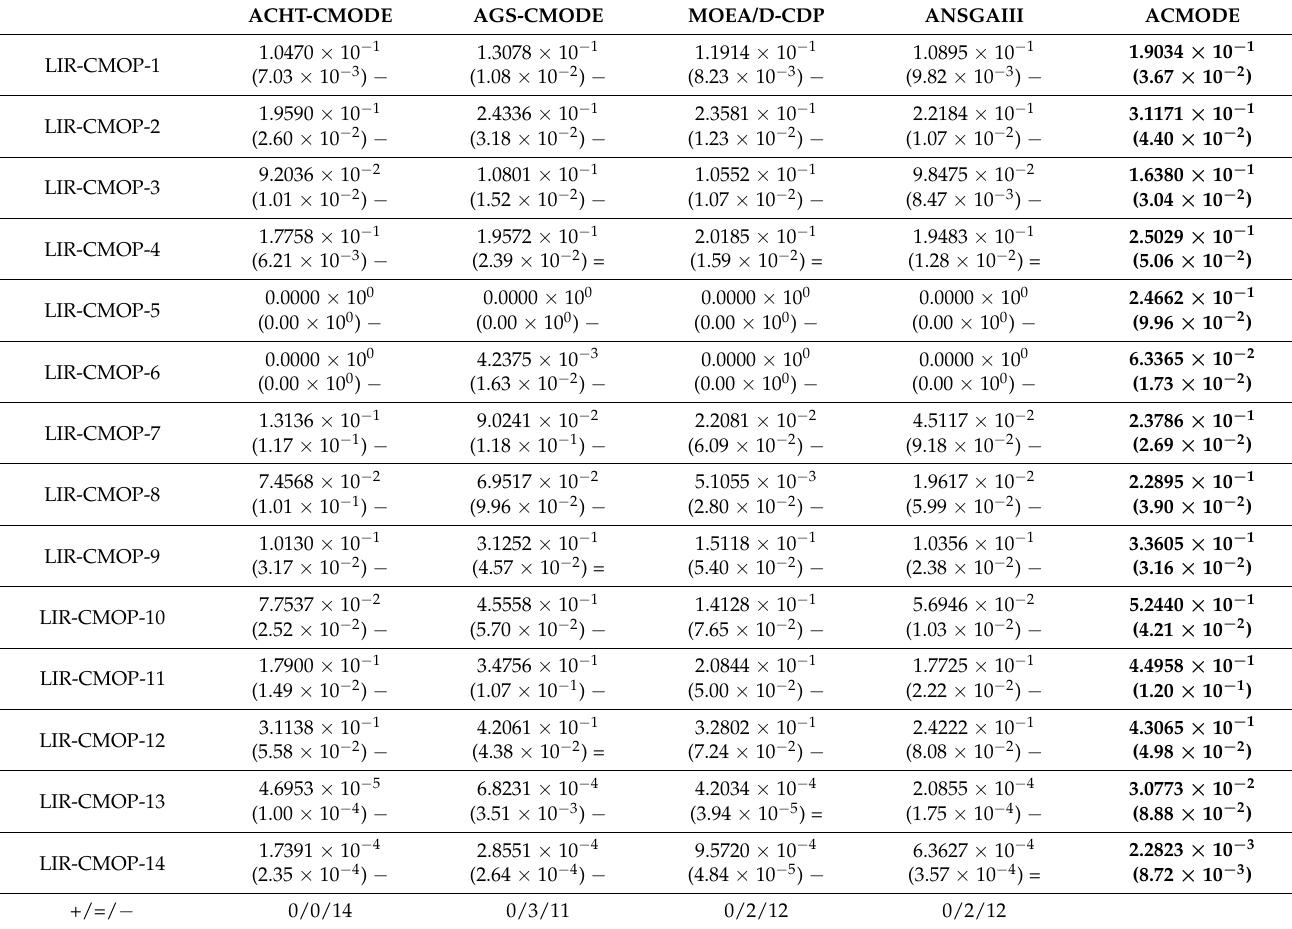
Table 5. HV results of all comparison algorithms on LIR-CMOP test